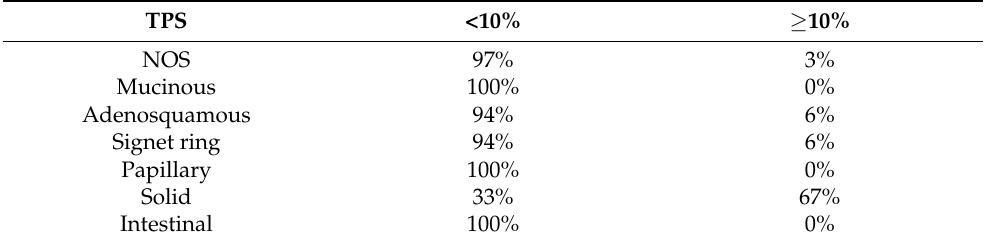
Table 3. Distribution of tumor morphologies, stratified for Tumor Proportion